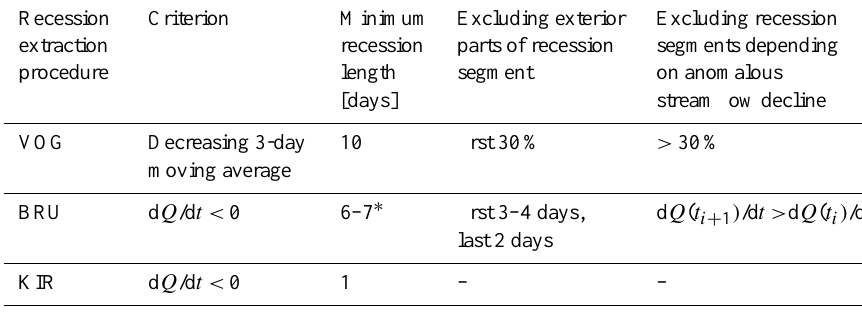
Table 1. Main criteria to extract recessions from streamflow